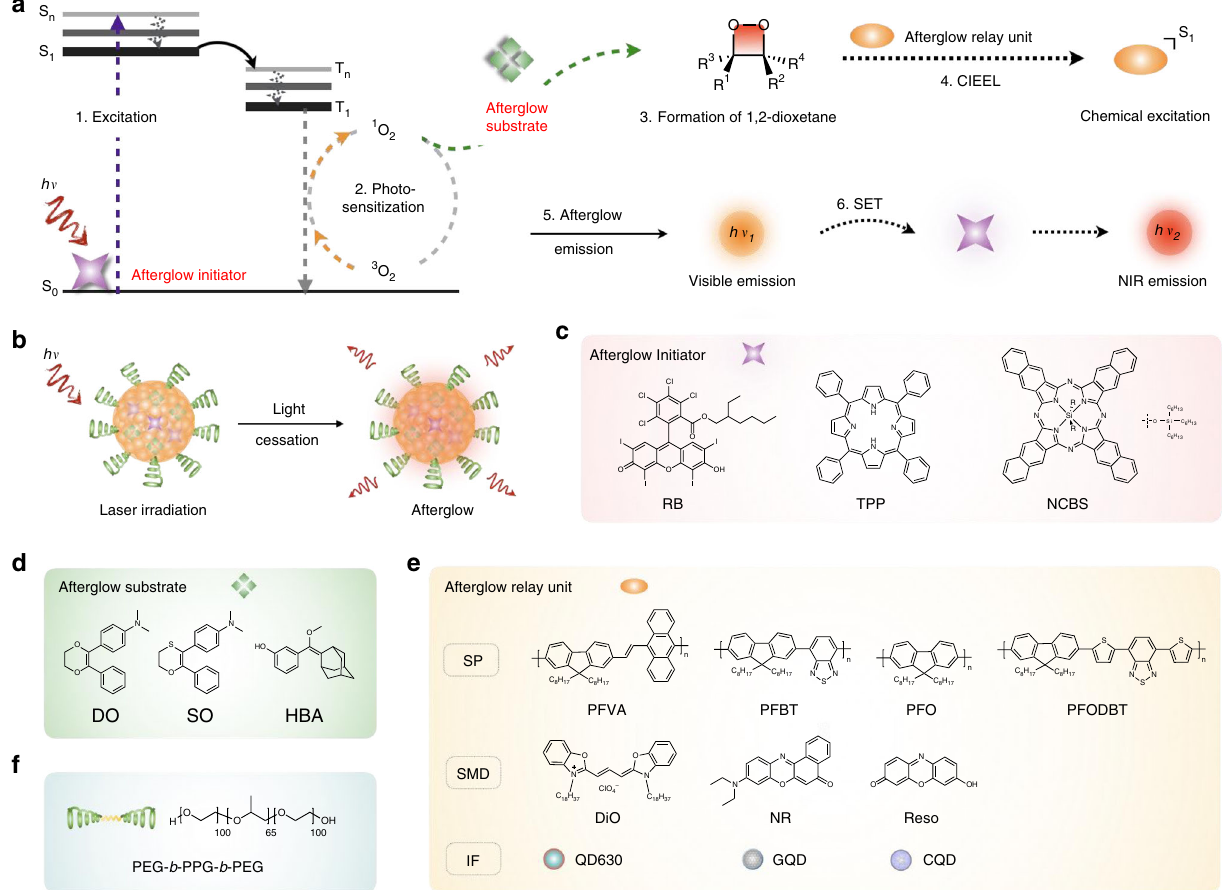
Fig. 1 The design approach toward afterglow luminescent nanoparticles (ALNPs). a Schematic illustration of detailed intraparticle photoreaction processes leading to afterglow. b Illustration of afterglow imaging of ALNPs. c – e Chemical structures of afterglow initiators ( c ), afterglow substrates ( d ), afterglow relay units ( e ), and amphiphilic copolymer ( f ). PFVA, poly[(9,9 ′ -dioctyl-2,7-divinylene fl uorenylene)- alt -(9,10-anthracene)]; PFBT, poly[(9,9 ′ - dioctyl fl uorenyl-2,7-diyl)- alt -(benzo[2,1,3]thiadiazol-4,7-diyl)]; PFO, poly(9,9 ′ -dioctyl fl uorenyl-2,7-diyl); PFODBT, poly[2,7-(9,9 ′ -dioctyl fl uorene)- alt -4,7- bis(thiophen-2-yl)benzo-2,1,3-thiadiazole]; DiO, 3,3 ′ -dioctadecyloxacarbocyanine perchlorate; NR, nile red; Reso, resoru fi n; QD630, CdSe/ZnS core-shell type quantum